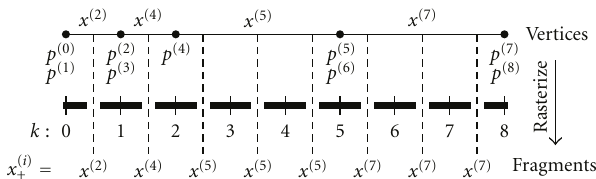
Figure 6: Particle selection on the GPU. The line segments are made up by the points N ( i − 1) and N ( i ) , which define a line where every segment represents a particle. Some line segments have length 0, that is, no particle should be selected from them. The rasterizer creates particles x according to the length of the line segments. The line segments in this figure match the situation in Figure 5.